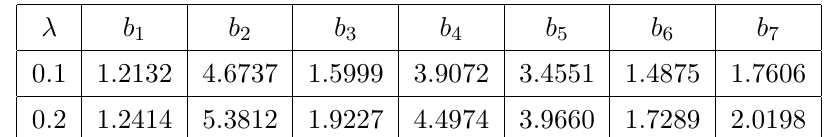
( k ) for q 2 = 1 . 4 . 3 / 2